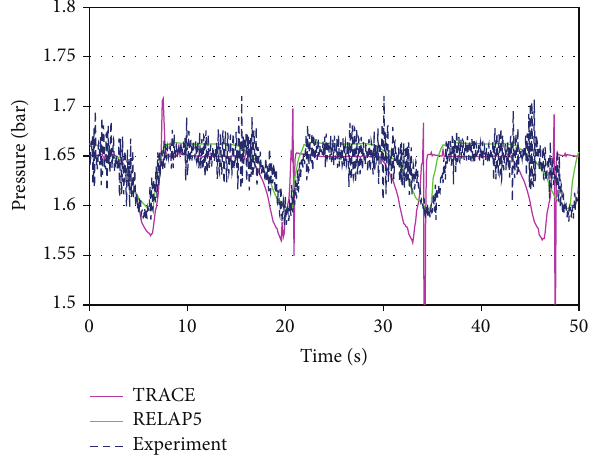
Figure 8: Test I-2: inlet